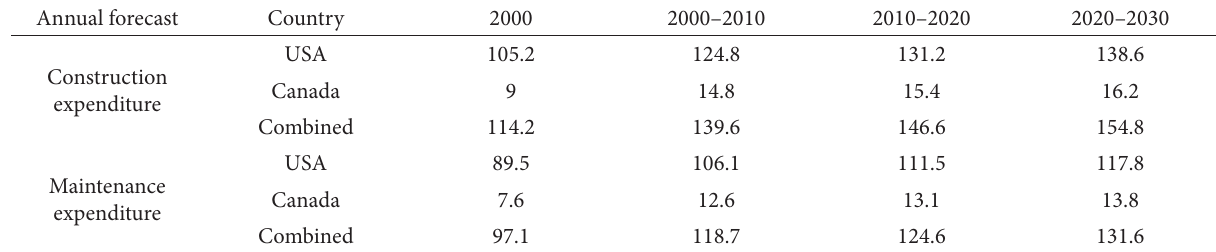
Table 2. Annual road construction and maintenance expenditure forecast for USA and Canada as examples of increased demands for road infrastructure funding, US $ billion (Parche 2007) Annual